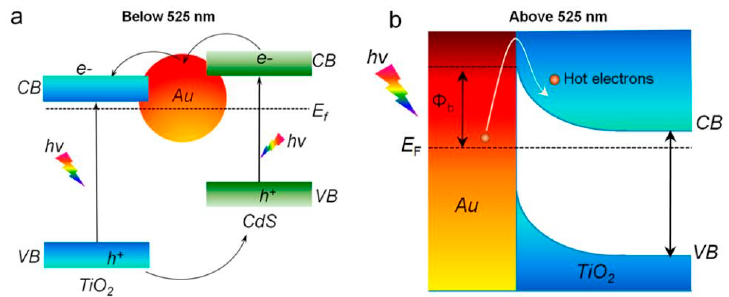
Figure 20. ( a ) Electron relay effect of Au nanoparticles, facilitating the charge transfer from CdS QDs to TiO 2 nanorods under the irradiation of incident solar light with a wavelength <525 nm. ( b ) Plasmonic energy transfer from the excited Au nanoparticles to TiO 2 through hot electron transfer under the irradiation of incident solar light with a wavelength >525 nm. CB = conduction band, VB = valence band, E F = Fermi energy level, and Φ b = Schottky barrier [112]. Copyright 2014 American Chemical